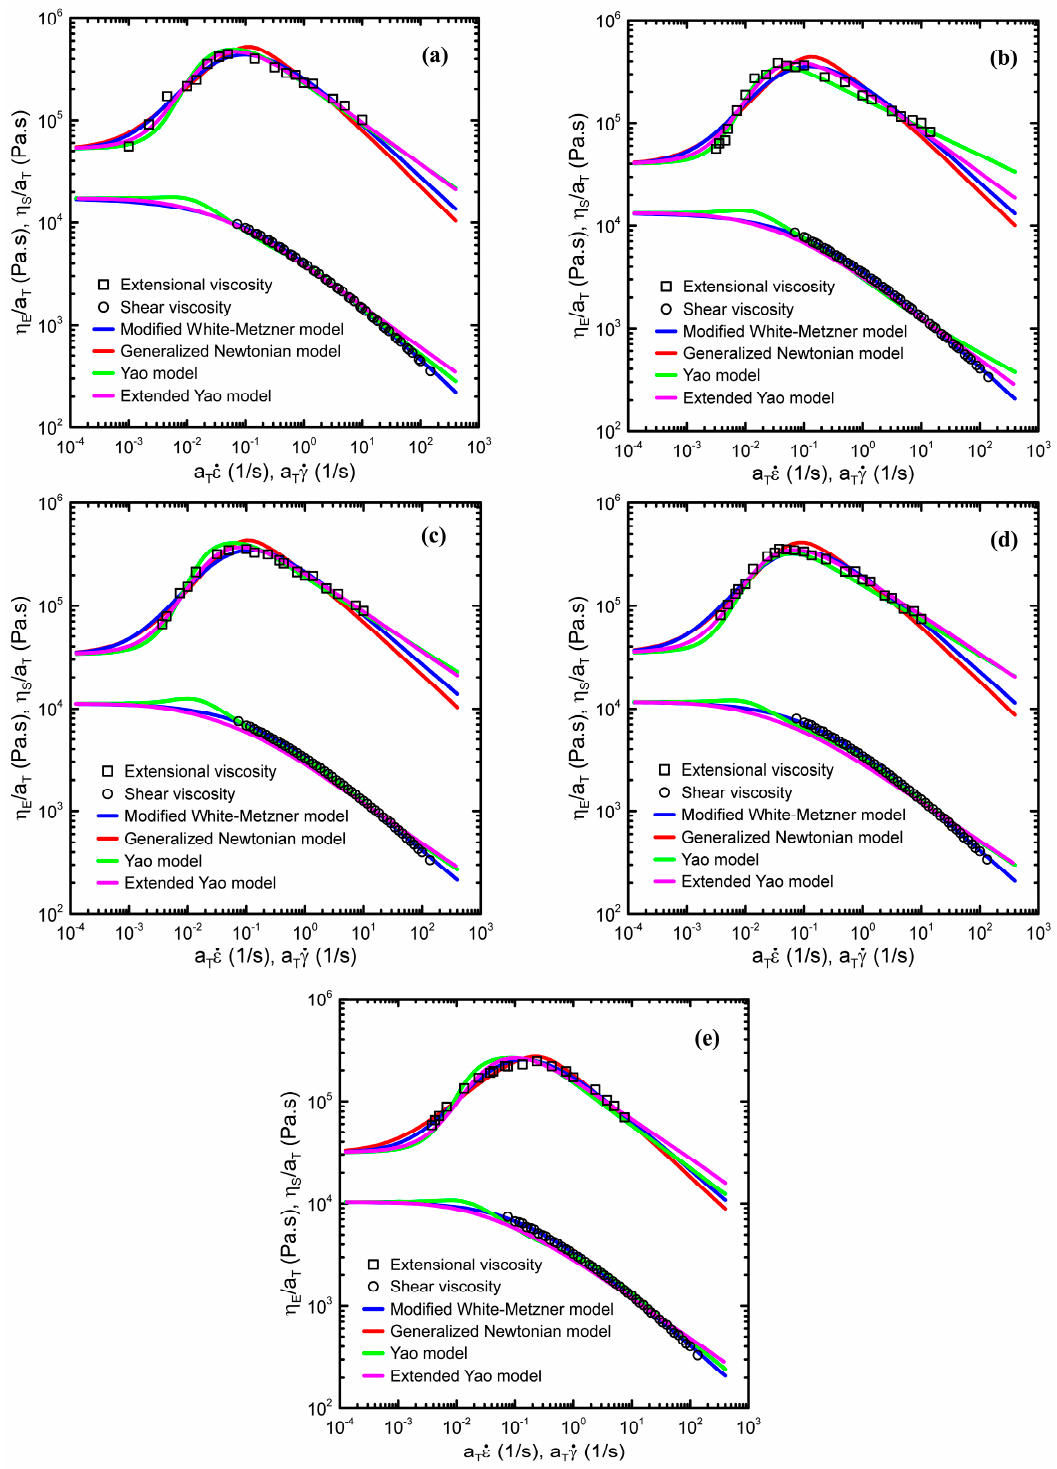
Figure 9. Comparison between the measured steady-state shear and uniaxial extensional viscosities and model fits at 180 °C. ( a ) Virgin PP; ( b ) 1 h degraded PP; ( c ) 3 h degraded PP; ( d ) 5 h degraded PP; ( e ) 7 h degraded PP.